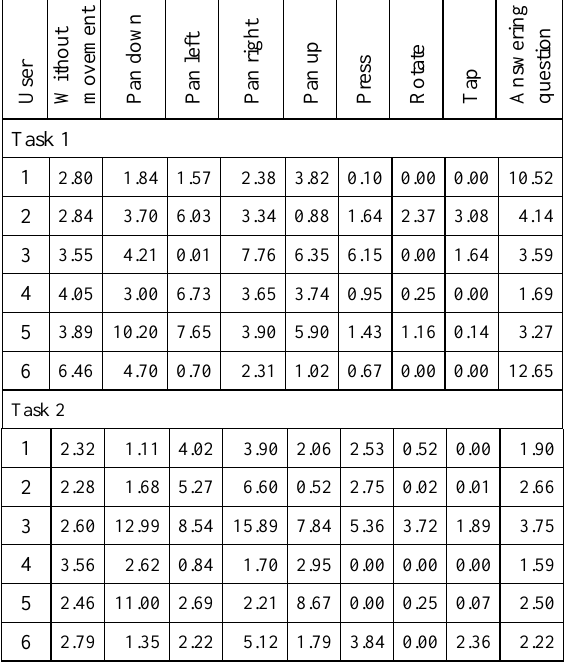
Tab. 2. Time spent by individual users by interaction through gestures (in seconds).